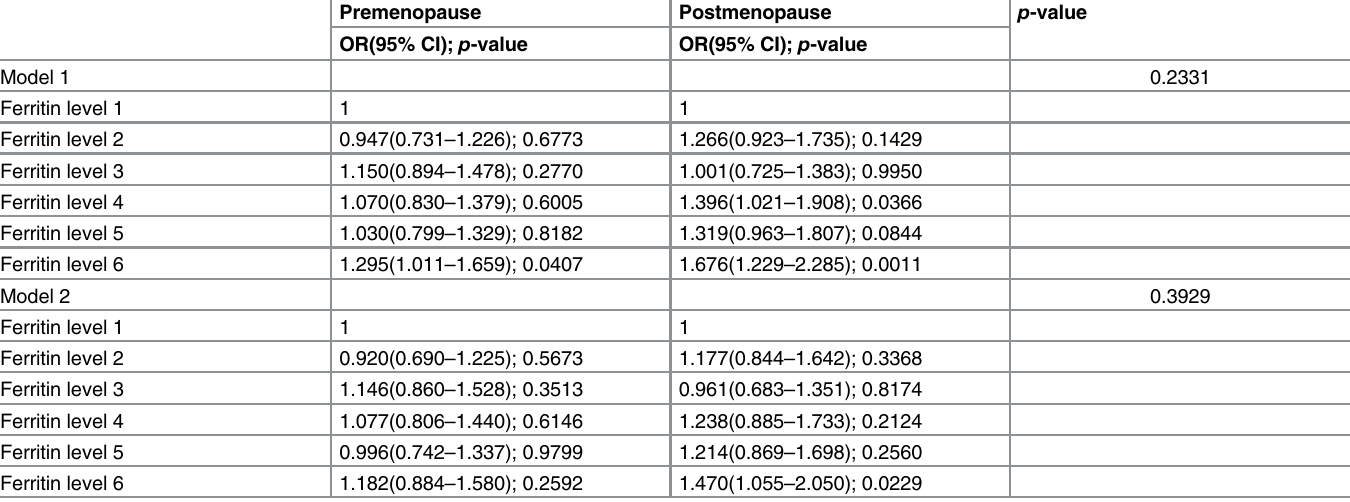
Table 3. Adjusted odds ratios (95% confidence interval) for BMI ( (cid:1) 25) by serum ferritin groups.